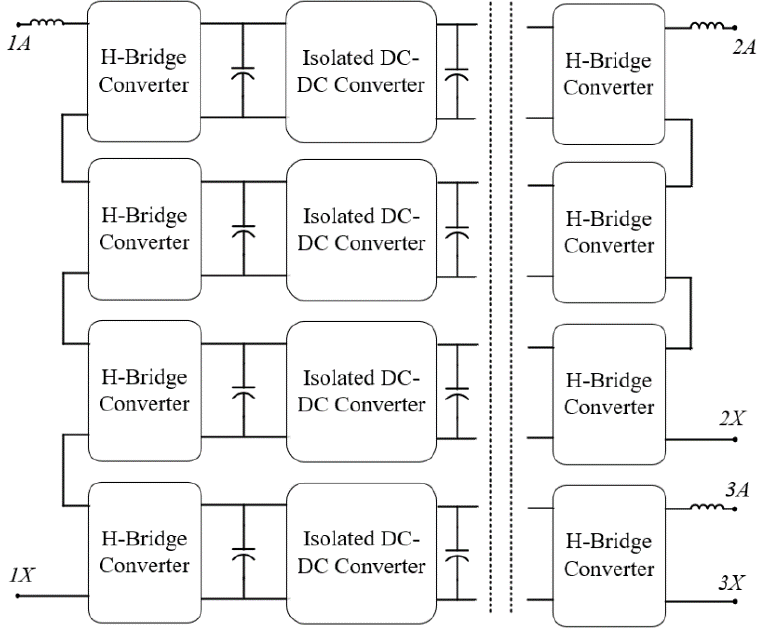
Figure 6. Single-phase representation of the UNIFLEX solid-state transformer topology. Regardless of the partially or fully isolation class, it is important to report that the QAB converter has also been tested as a possible feasible basic cell for a three-port SST [46,47]. This is because a generic n -winding isolated DC-DC converter can be connected to less than n different ports. In this case, any port is coupled with the others through more than either in a symmetrical or in an asymmetrical way, providing different solutions to the voltage and power level for the isolating stage of the converter.